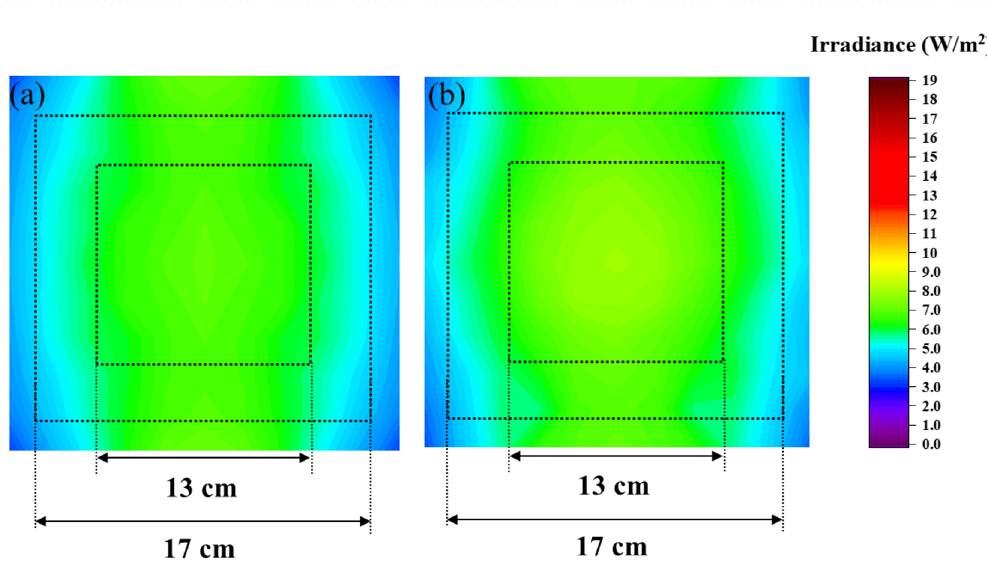
Figure 3. The light pattern of the middle section in ( a ) simulation and ( b )